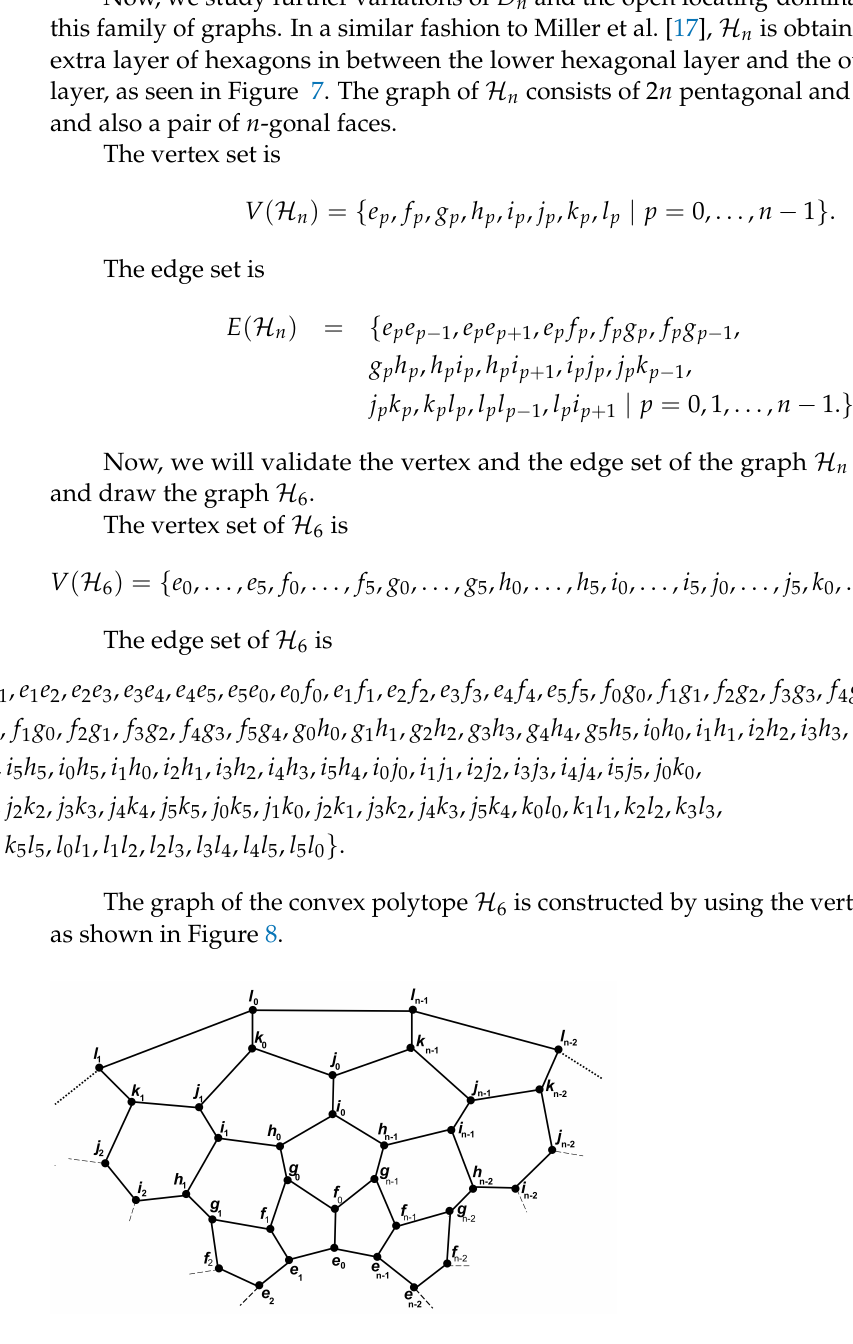
Figure 7. The graph of convex polytope H n